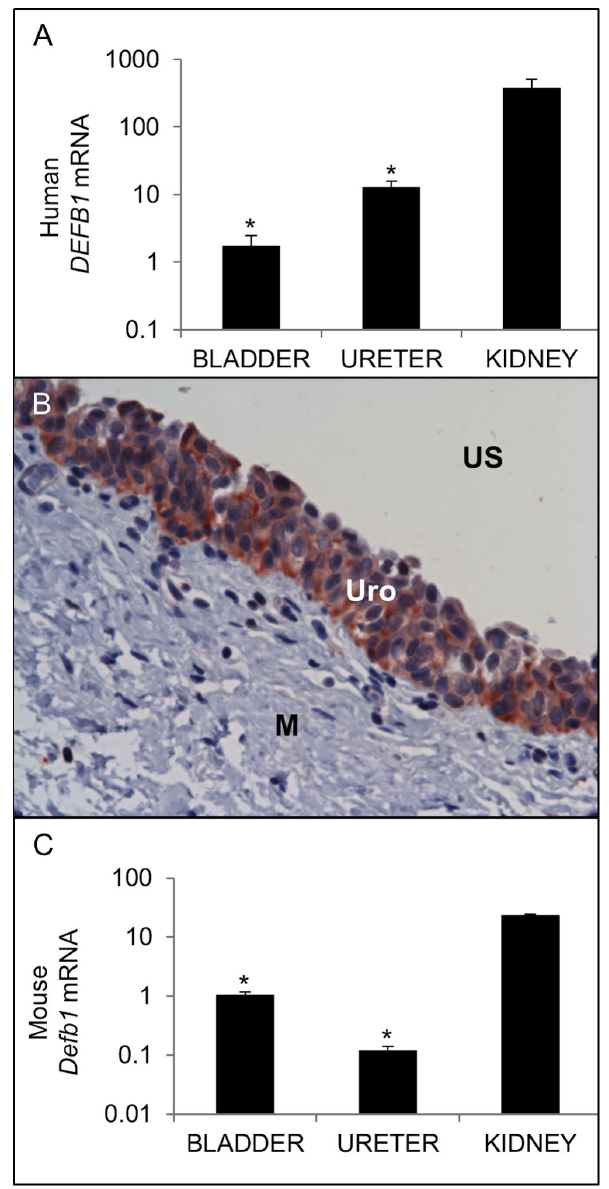
Figure 1. Expression of BD-1 in the uninfected urinary tract. (A) Expression of human DEFB1 mRNA (TOP) and mouse Defb1 mRNA (BOTTOM). Samples were normalized for GAPDH / Gapdh content and expressed as fold-difference compared to a pool of uninfected human / mouse bladder cDNA using the 2^-ΔΔCT method[22]. * indicates p < 0.05 in 2- tailed student’s t -tests comparing indicated organ to kidney. The average fold change ± standard error of the mean (S.E.M.) for each organ is shown (n=4 bladders, 2 ureters, 3